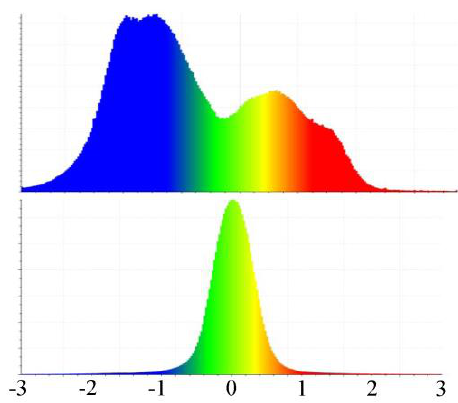
Figure 7. Histograms of the M3C2 differences between the 1 st and the 2 nd scan of the roof segment, before and after the calibration (in